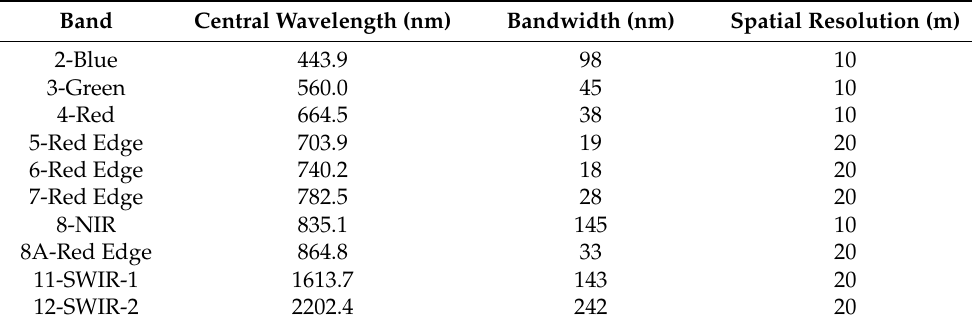
Table 1. Multispectral band parameters of sentinel-2 satellite.